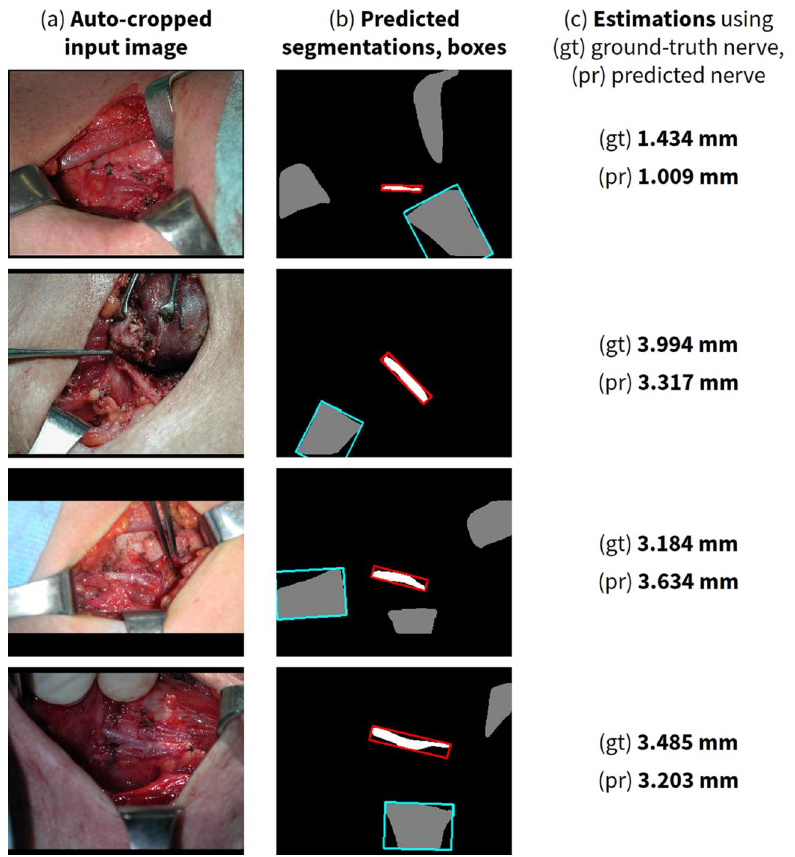
Figure 4. Nerve width estimation with qualitative and quantitative evaluation. Examples of nerve width estimations with ( a ) the automatically cropped original input image, ( b ) predicted segmentations and corresponding bounding boxes for nerve in white and red respectively, and for retractor in gray and blue respectively, and ( c ) estimated maximum nerve width using the reference retractor width of 15 mm and (gt) ground-truth nerve segmentations and (pr) predicted nerve segmentations (predicted retractor segmentations are used across both estimates for consistency, as some images did not have ground-truth retractor annotations). Overall, the estimations derived from both ground-truth and predicted nerve segmentations are similar. Nota bene : these representative images of the RLN are taken from a variety of anatomic locations within